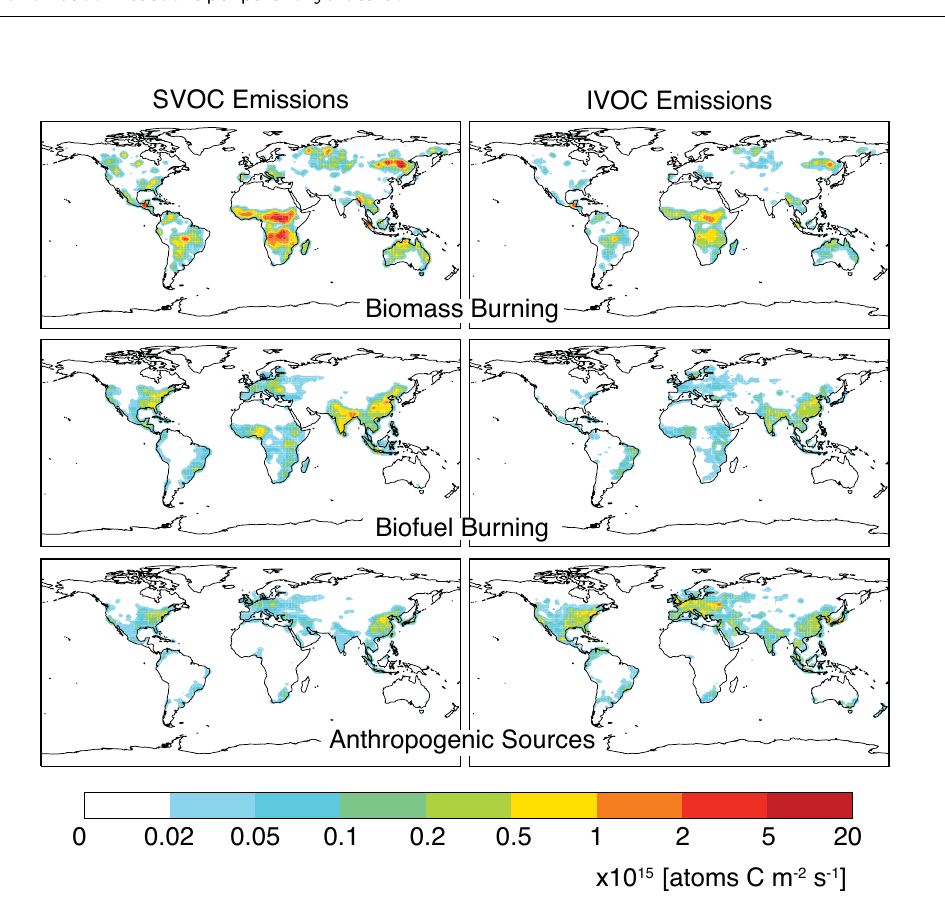
Fig. 1. Emissions of SVOCs and IVOCs. SVOC emissions shown here are the baseline POA emission inventory. Plots are annual averages for year 2000. Note that the color scale is not